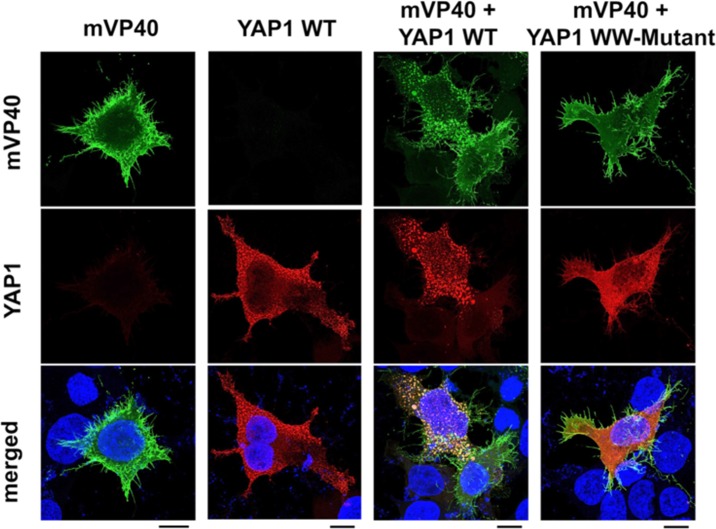
Intracellular localization of mVP40 and YAP.HEK293T cells were transfected with YFP-mVP40 alone, CFP-YAP1 WT alone, YFP-mVP40 + CFP-YAP1 WT, or YFP-mVP40 + CFP-YAP1 WW mutant (0.25μg/each). Confocal images for each condition are shown with mVP40 in green, YAP in red, and nuclei in blue. Overlap of YFP-mVP40 and CFP-YAP WT is indicated by yellow fluorescence in merged images. Scale bars = 10μm.